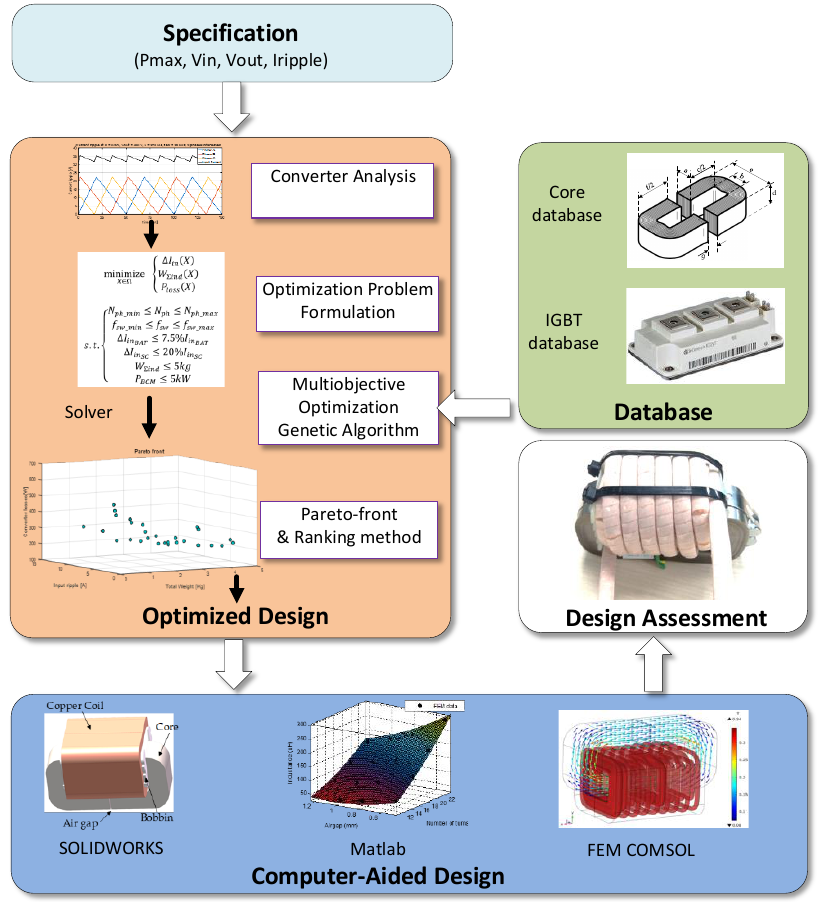
Figure 3. Proposed design optimization